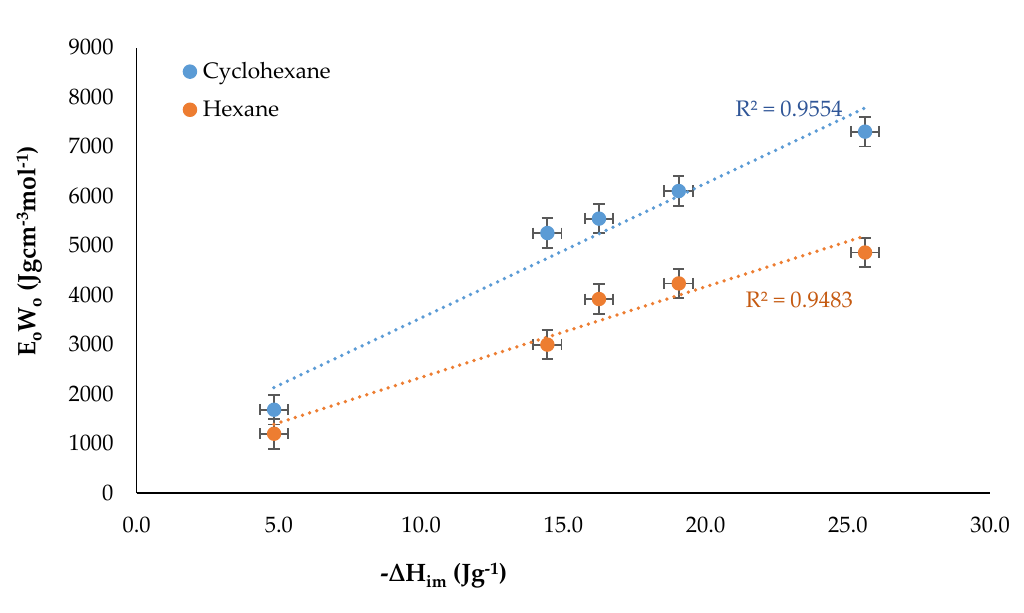
Figure 9. E o W o obtained from the enthalpy of immersion of activated carbons into the solvents in function of the immersion enthalpy of the solvents.